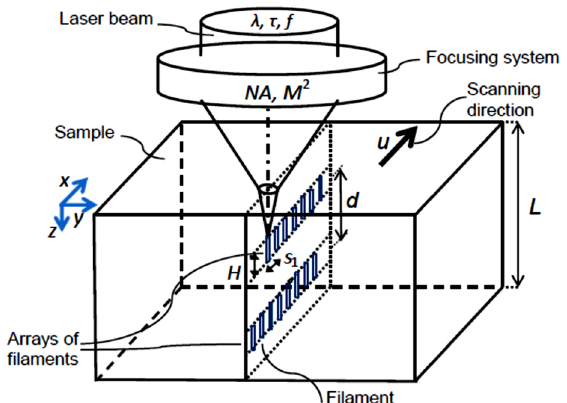
Figure 1. Irradiation scheme explaining the main parameters of the model. Each filament is created by a single laser pulse of a focused beam from a pulse-periodic fs, or ps laser, λ is its wavelength, τ is pulse duration, f is pulse repetition rate (PRR), u is the velocity of beam scanning across the material. The focusing system and the laser beam are described by the standard parameters NA and M 2 . L is the thickness of the irradiated sample, s 1 is the distance between neighbouring filaments inside the material, H is the length of the single filament, and at the same time, the width of one array of filaments, d is the vertical distance between adjacent arrays of filaments. The beam scans the material in the xy -plane, the z -axis is directed into the material depth and coincides with the direction of the filament axis.